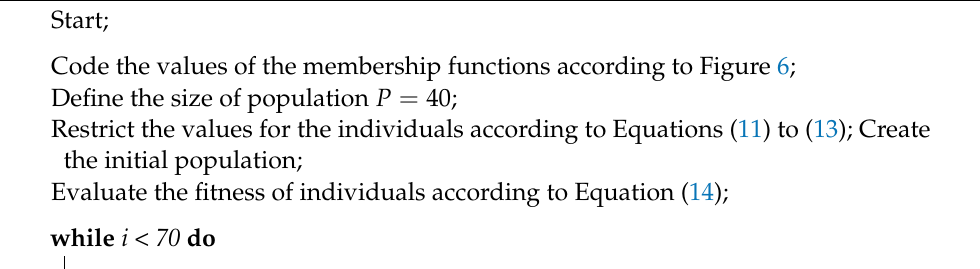
Algorithm 2: Pseudocode of the